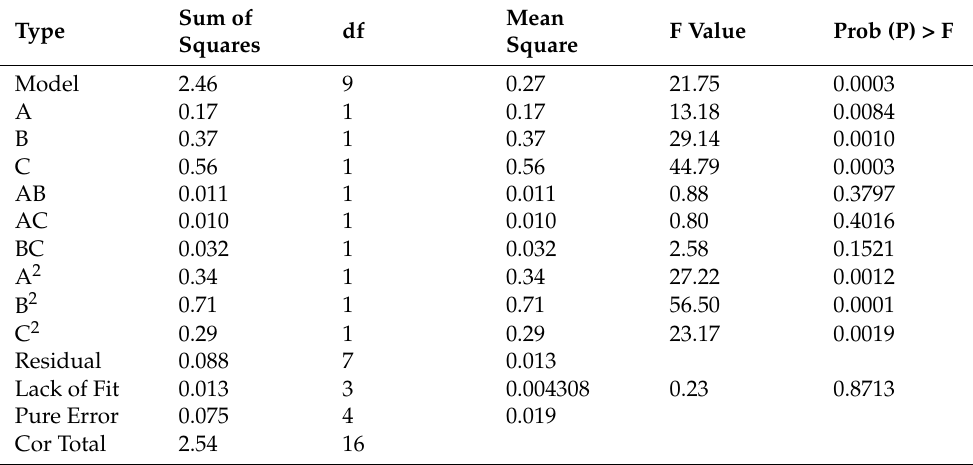
Table 4. ANOVA for the regression quadratic model equation of